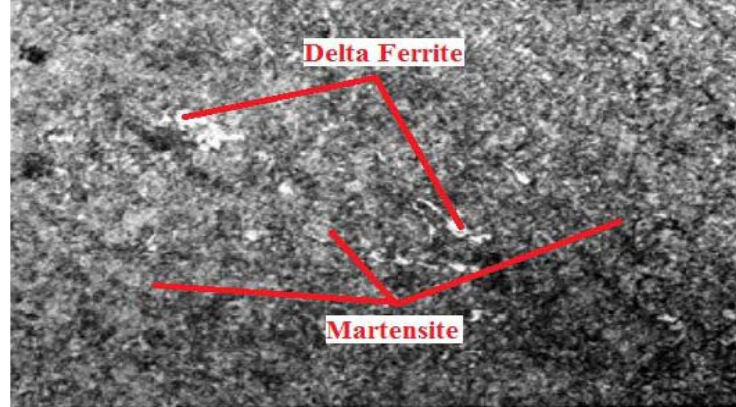
Fig. 2. The microstructure of soluble treated samples at a temperature of 1100 °C (50X).